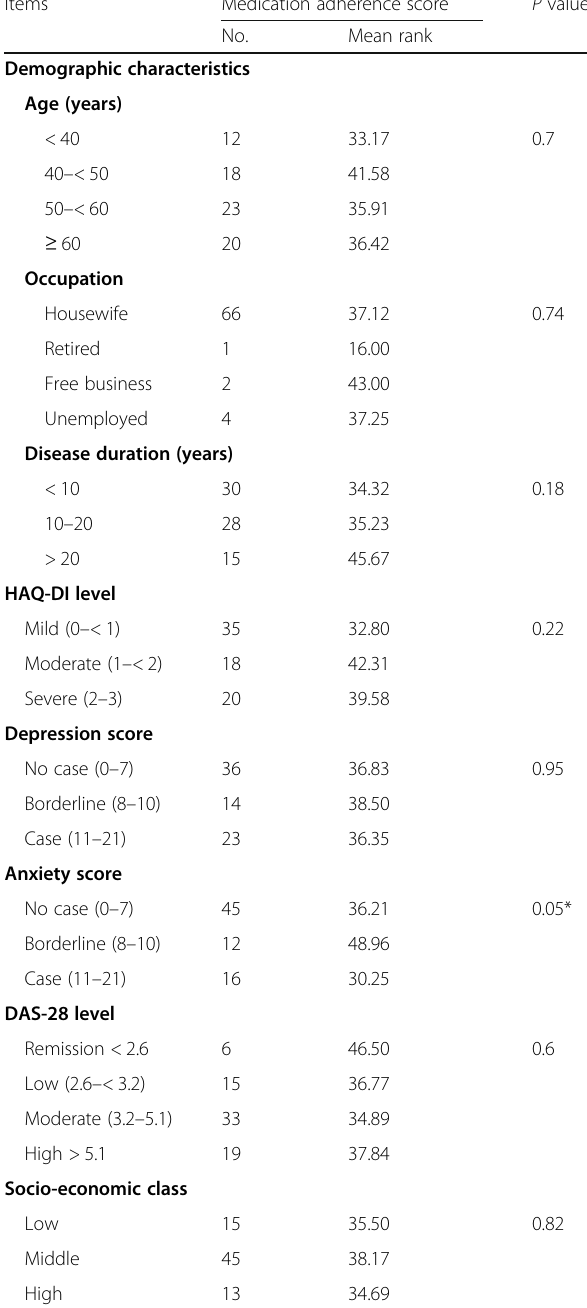
Table 5 Relation between medication adherence score and some demographic and clinical data, HAQ-DI level, depression score, anxiety score, DAS-28 level, and socio-economic class among studied patients (No. =